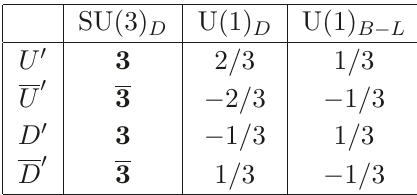
Table 1 . Charge assignment of the dark quarks for a composite ADM model. SU(3) D and U(1) D are gauge symmetries of the dark sector, while U(1) B − L is the global symmetry shared with the visible